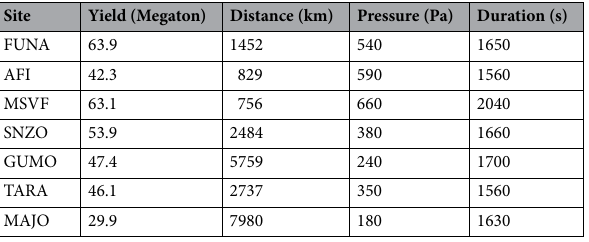
Table 1. The estimated yield from barometric observations within 8000 km from